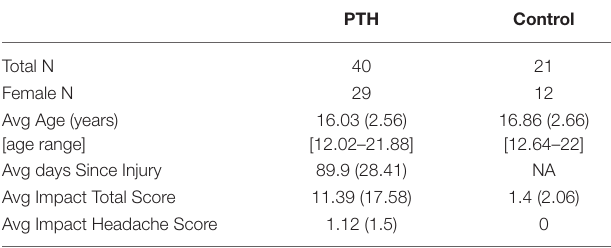
TABLE 1 | Participant